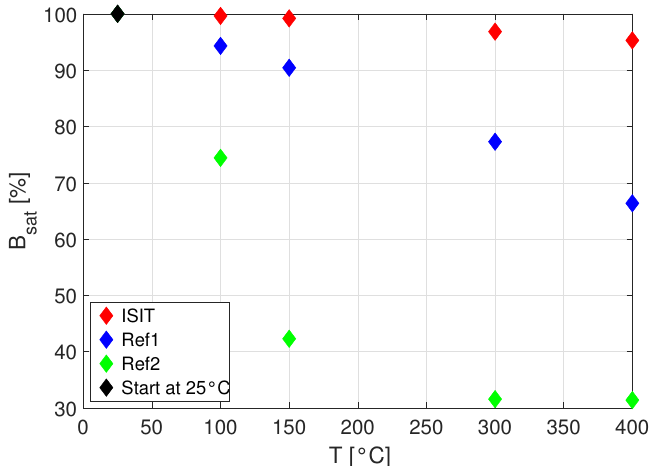
Figure 12. Magnetic saturation flux density B sat versus